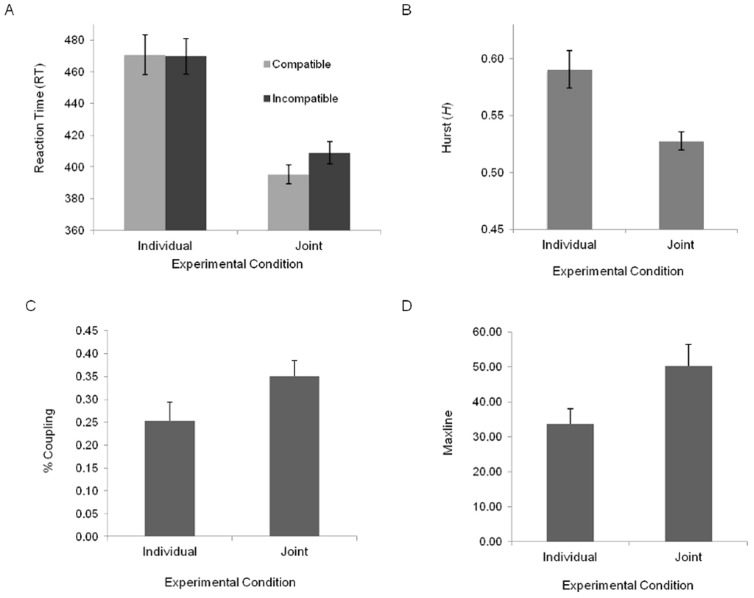
Results of linear and non-linear analyses.(A) Mean reaction time (RT) as a function of experimental condition and compatibility; (B) mean Hurst (H) as a function of experimental condition; (C) the percent coupling, (D) and maxline calculated using instantaneous cross correlation as a function of experimental condition.